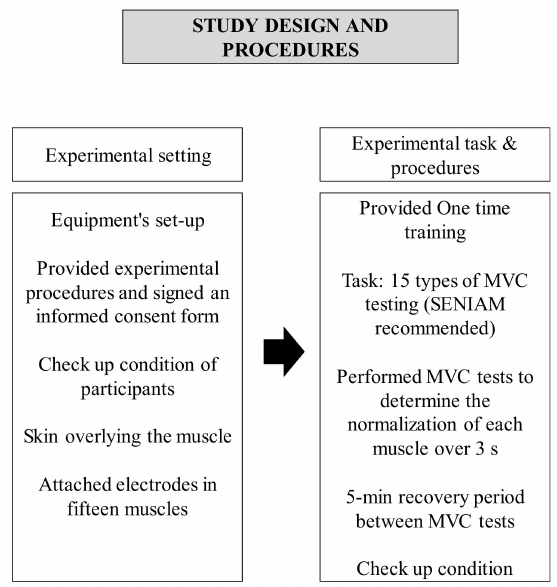
Figure 2. Study design and procedures.